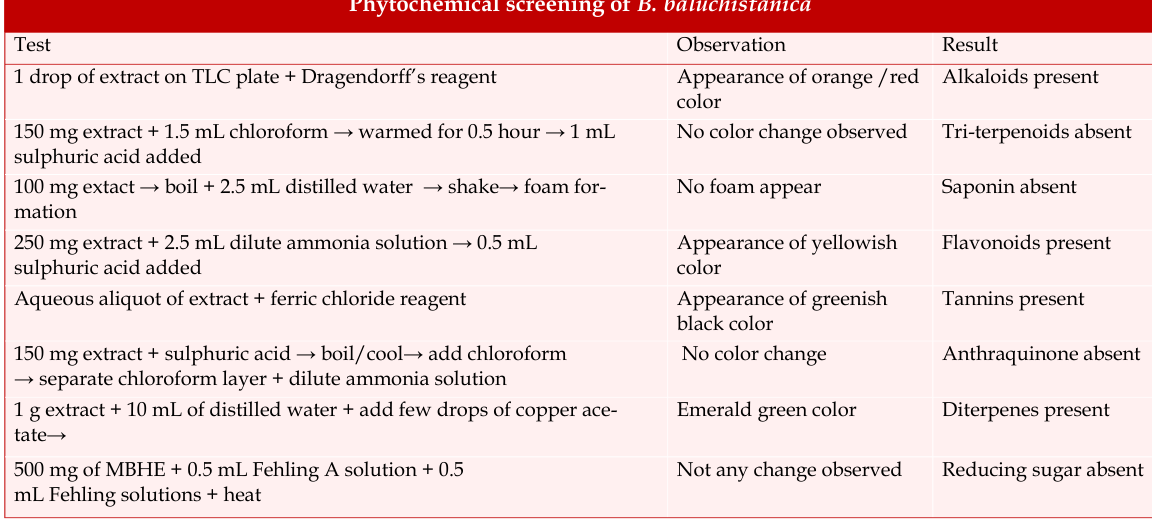
Phytochemical screening of B. baluchistanica